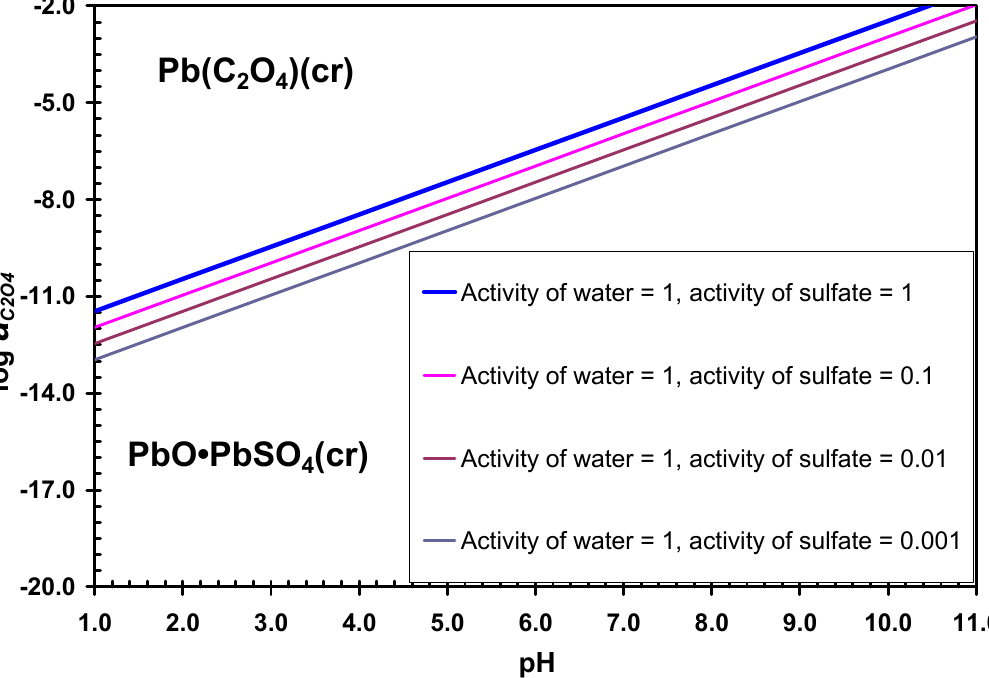
°C in the space of 2 25 ◦ C in the space of log a of lead pastes. desulphurization of lead pastes.